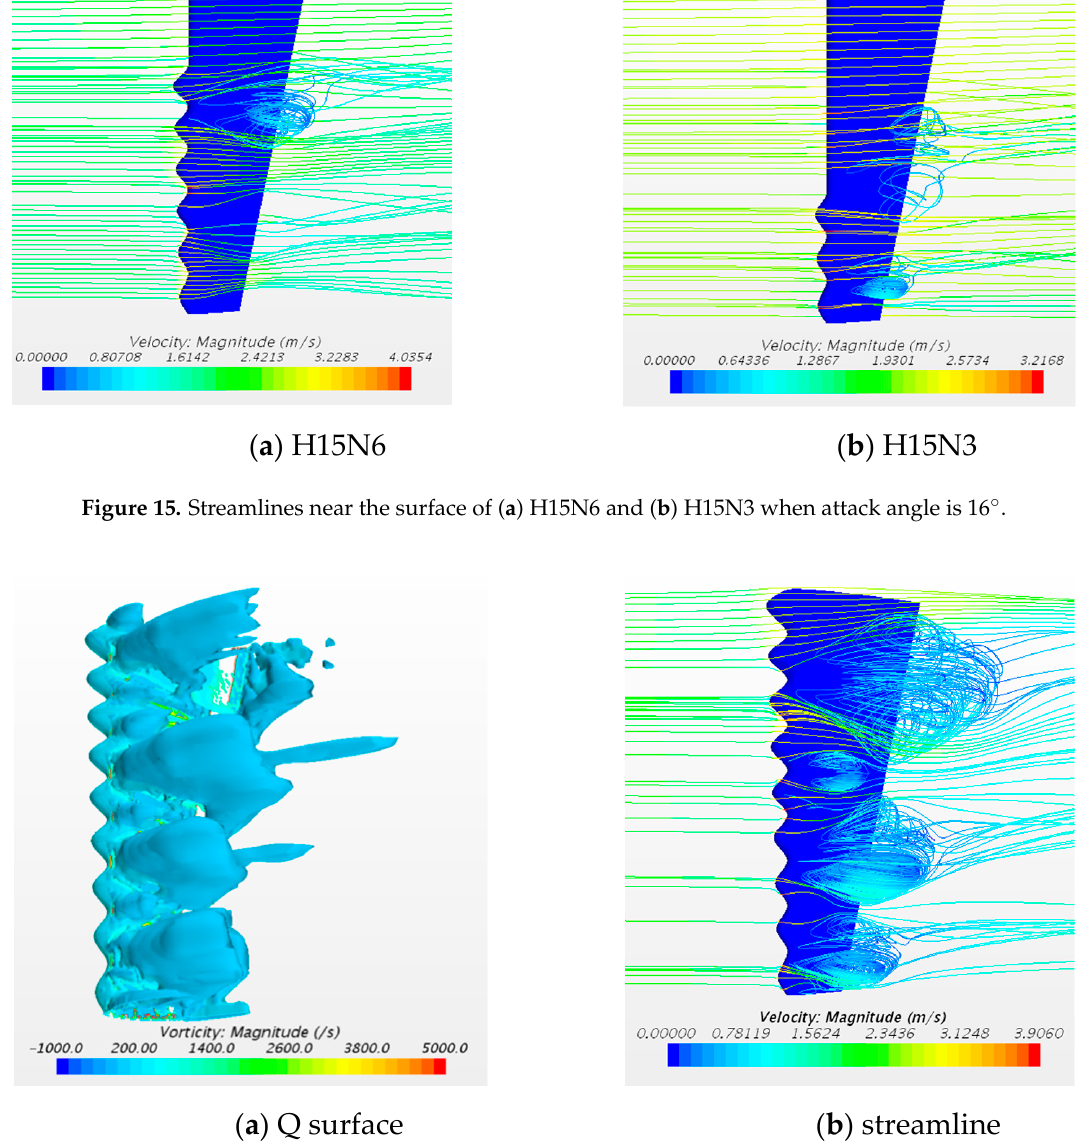
Figure 16. Vortex structures and streamlines near the surface of H15N9 when attack angle is 24° (the iso-surfaces in ( a ) corresponds to Q = 150 and velocity magnitude contour of streamline in ( b )).